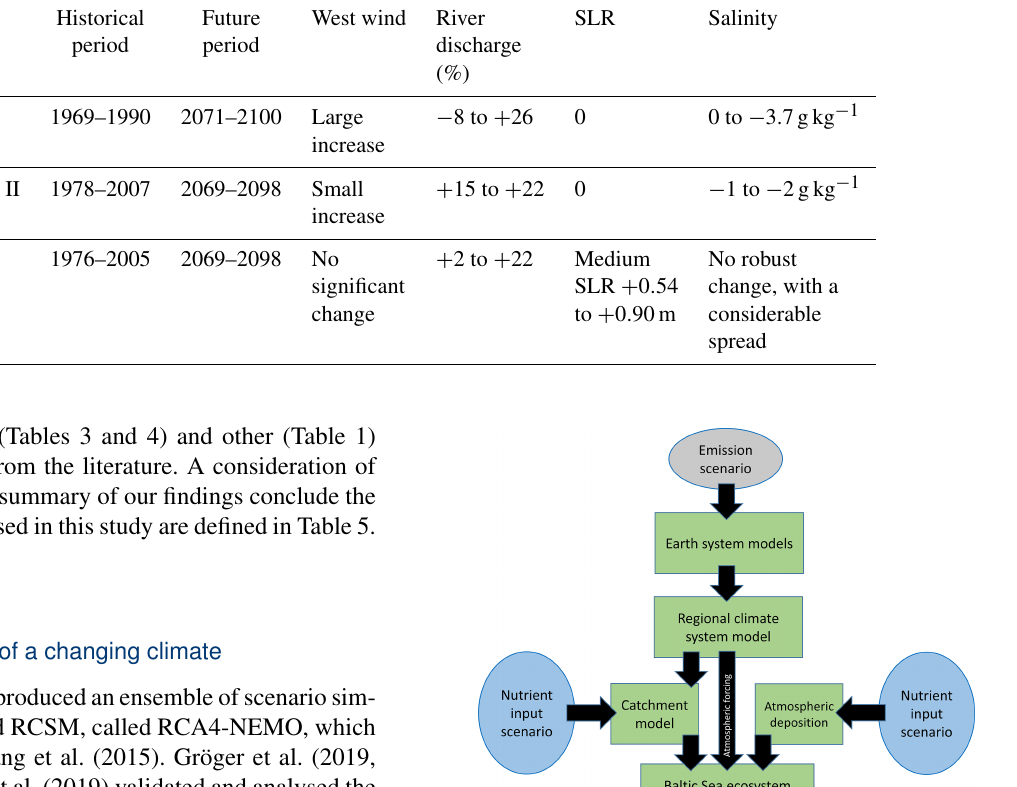
Table 2. Salinity projections assessed by the BACC Author Team (2008), BACC II Author Team (2015) and BEAR (this study). Salinity changes depend on the changes in the wind field (in particular, the west wind component), river discharge and sea level rise (SLR). The changes refer to the mean differences between historical and future periods. (Data sources: Meier et al., 2006, 2011b, 2021).